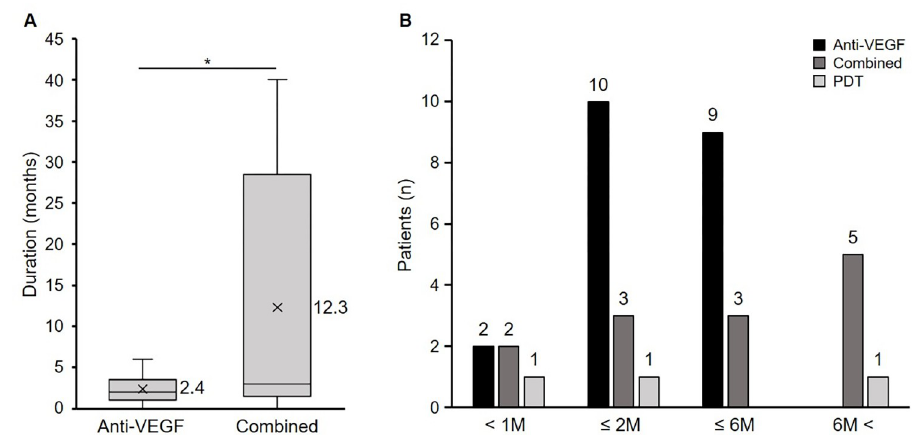
Fig 2. Time from the last intervention to the onset of the SMHs. A: The mean time from the last treatment to the onset of the SMHs was significantly shorter in the anti-vascular endothelial growth factor (VEGF) monotherapy group than in the combined group ( P < 0.01 unpaired t-test). B: The anti-VEGF monotherapy group had more patients with a shorter duration to the onset of the SMHs. Combined = combined therapy with anti-VEGF and photodynamic therapy; PDT: photodynamic monotherapy. M = months.